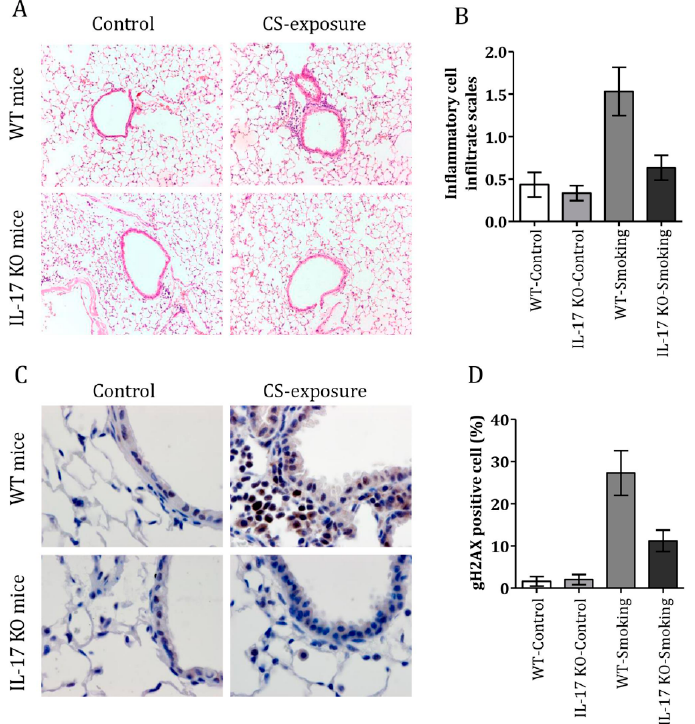
Figure 4. Cigarette smoke induced airway inflammation and a DNA damage response in IL-17 KO mice. ( A ) H&E staining of lung tissue in IL-17 KO and C57BL/6 mice with or without cigarette smoke